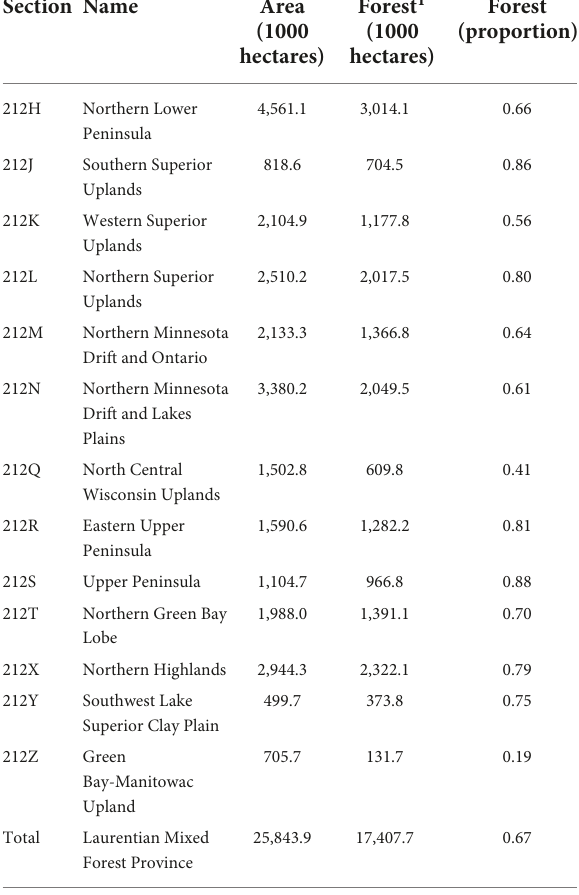
TABLE 6 Ecological sections of the Laurentian Mixed